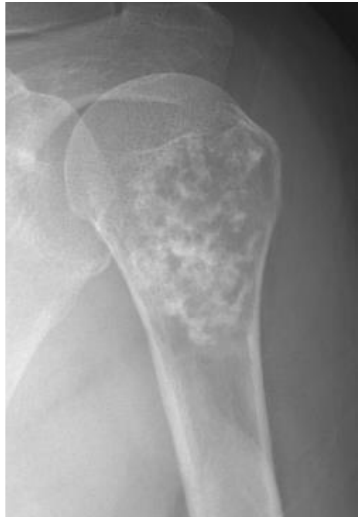
Figure 2. Atypical cartilaginous tumor of the humerus in a 59-year-old woman. Anteroposterior shoulder radiograph shows a mixed lytic and sclerotic lesion in the humerus. The sclerotic component represents typical chondroid ring-and-arc calcification.